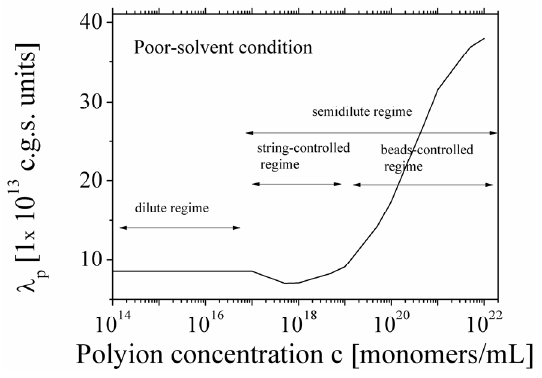
of polyions in poor-solvent Figure 5. Behavior of the equivalent conductance λ p condition, as a function of the polyion concentration. According to the scaling picture, three different concentration regimes are clearly shown. In the dilute regime, the conductance is independent of the concentration. In the semidilute regime, a string-controlled regime and a beads-controlled regime are dependent on the